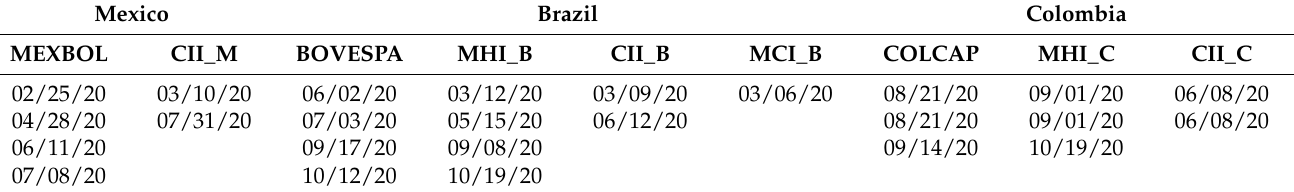
Table 1. Breaks in the variance for all countries and country-specific indexes.